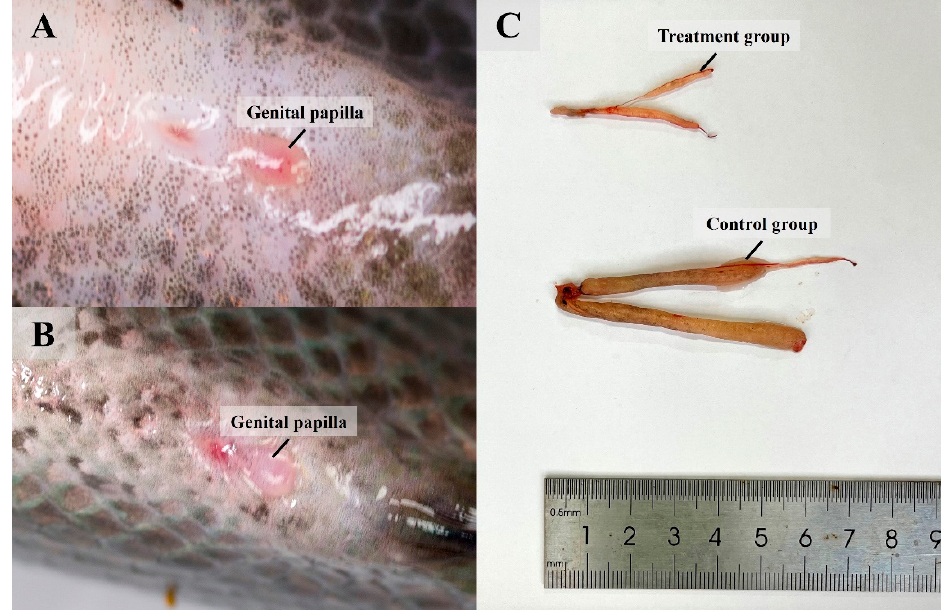
Figure 3. Down-regulation of amh inhibited development of sex organs and testis tissues in male Nile tilapia. ( A ) Effect of down-regulated amh in treatment group; ( B ) male fish in control group; ( C ) Comparison of testis tissue between treatment group and control group.